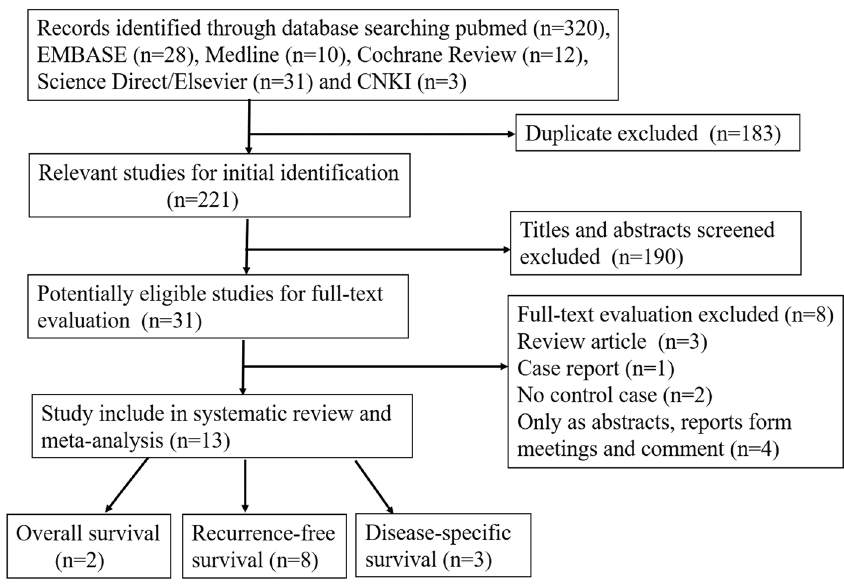
Figure 1: Flow diagram of the study selection